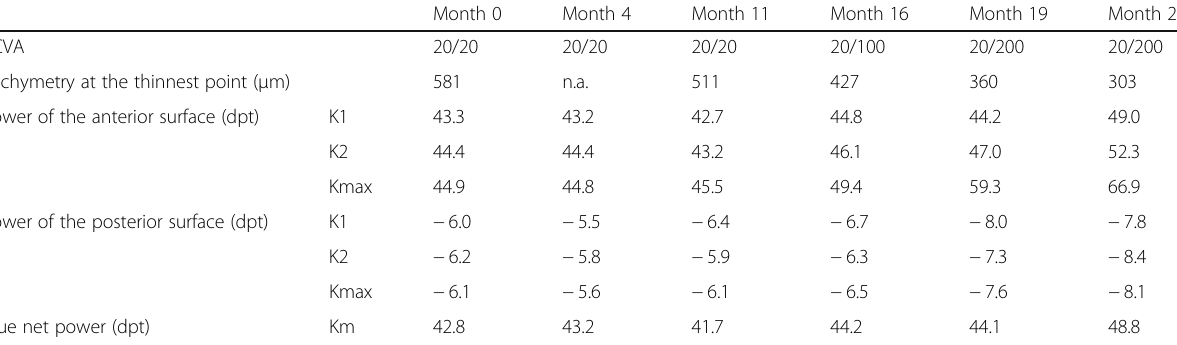
Table 1 Evolution of the left eye